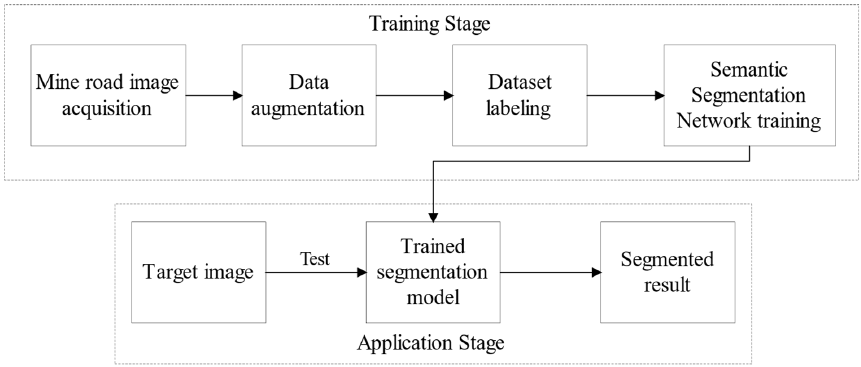
Figure 1. Underground mine road image segmentation flow chart. BiSeNet is used as the basic network model for semantic segmentation of under- ground mine slopes. The BiSeNet network designs two branch networks, namely Spatial Path and Context Path (CP). Aiming at the problem of spatial information loss in semantic segmentation, the spatial path solves the problem of spatial information loss by acquiring more low-level features, thus encoding rich spatial information, while the context path provides a larger receptive field.